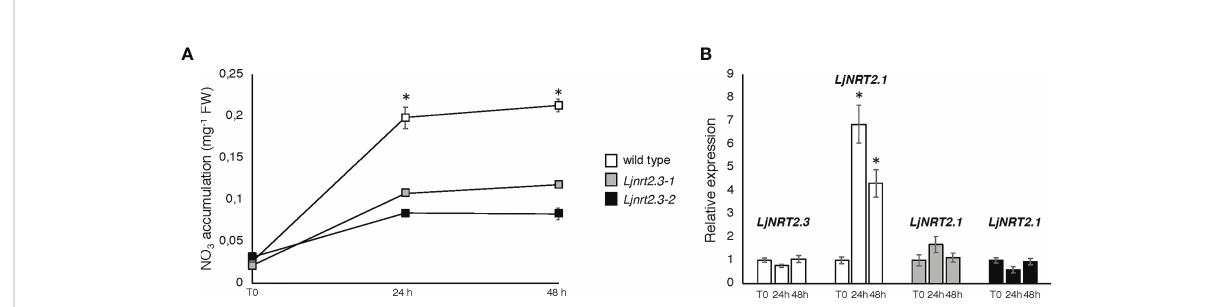
FIGURE 5 Plants were grown for 8 days on B5 derived medium supplemented with 8 mM KNO 3 as sole N source and then transferred under N starvation conditions for 6 days. At the end of the LjNRT2.3 induction period, plants were transferred on the same medium supplemented with 0.5 mM KNO 3 (T0) to score nitrate content and expression pro fi les at 24 and 48 hrs. (A) Nitrate content in roots of wild type and Ljnrt2.3 plants. Data represent means and SE from three independent experiments (8 plants per experiment). Asterisks indicate signi fi cant differences (p<0.001) of nitrate content in wild type and Ljnrt2.3-1 plants. (B) Pro fi les of LjNRT2.1 and LjNRT2.3 expression in roots of wild type and Ljnrt2.3 plants in response to 0.5 mM KNO 3 repletion. Data bars represent means and SD from three independent experiments. Asterisks indicate signi fi cant differences as relative to expression at T0 (*p<0.0001). The plant genotypes are